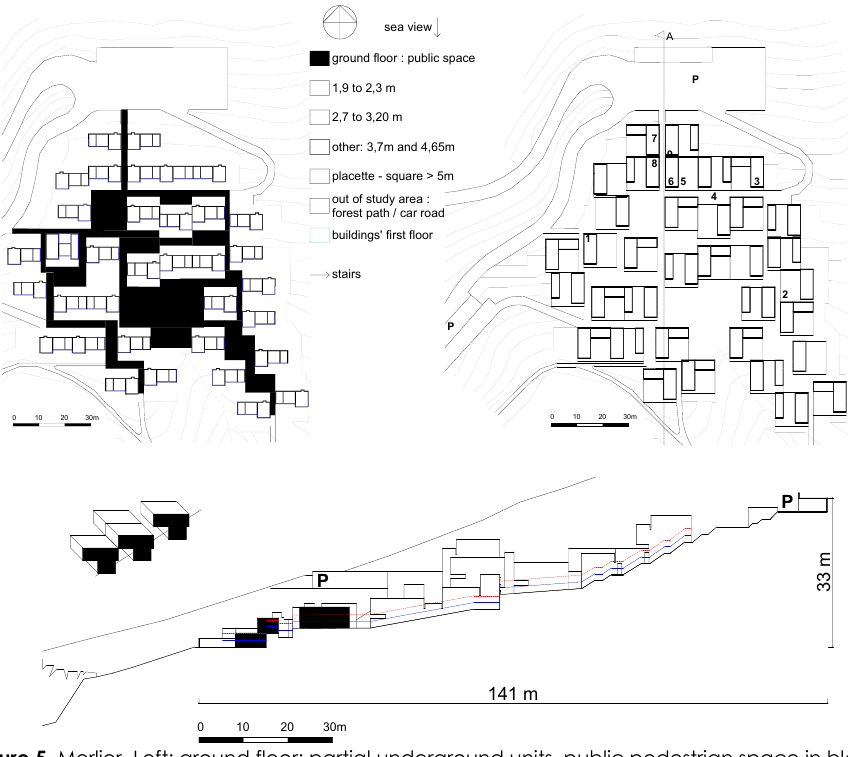
Figure 5. Merlier. Left: ground floor: partial underground units, public pedestrian space in black Right: first-floor plan: pedestrian street widths and SVF locations Bottom left: schematic diagram of the grid assembly of units on a slope; Bottom right: Section A. Red line: mean building height; Blue line: Absolute Rugosity or mean urban canopy